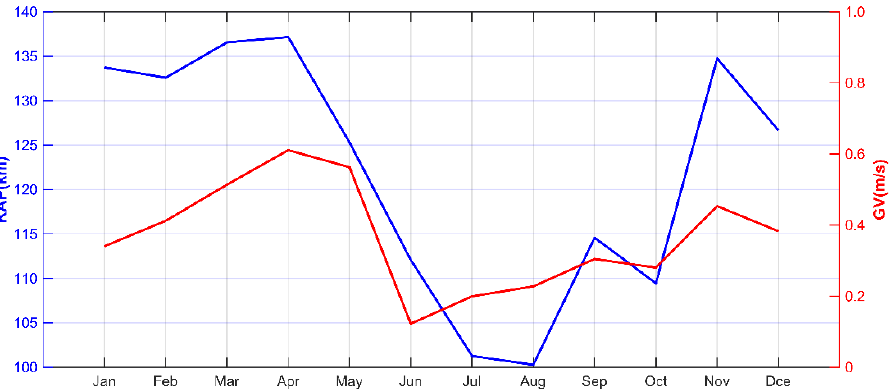
Figure 14. The climatological monthly Kuroshio axis position (blue solid line) and the climatological monthly geostrophic velocity amplitudes (red solid line) at the